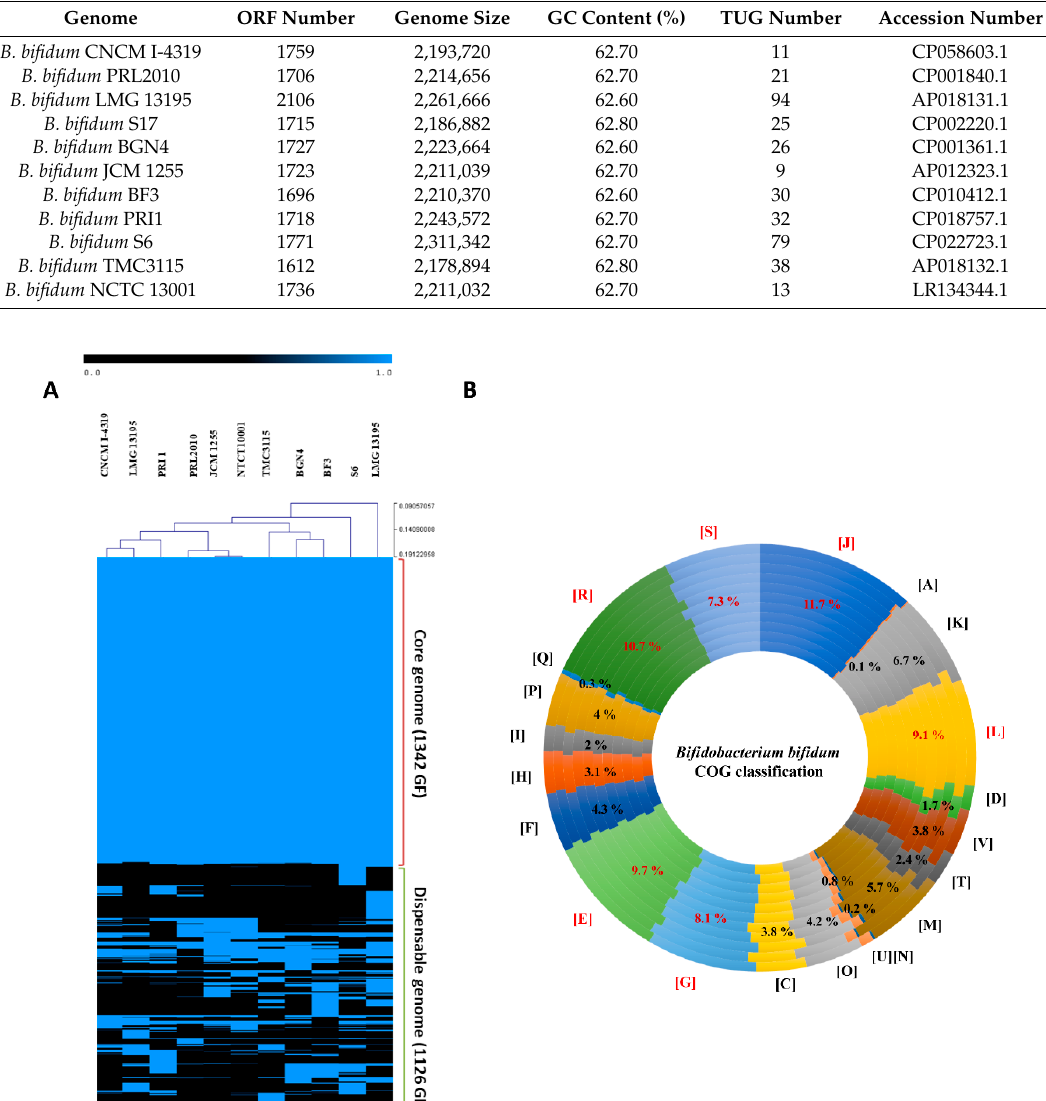
Table 1. B. bifidum genomes used for comparative analysis.